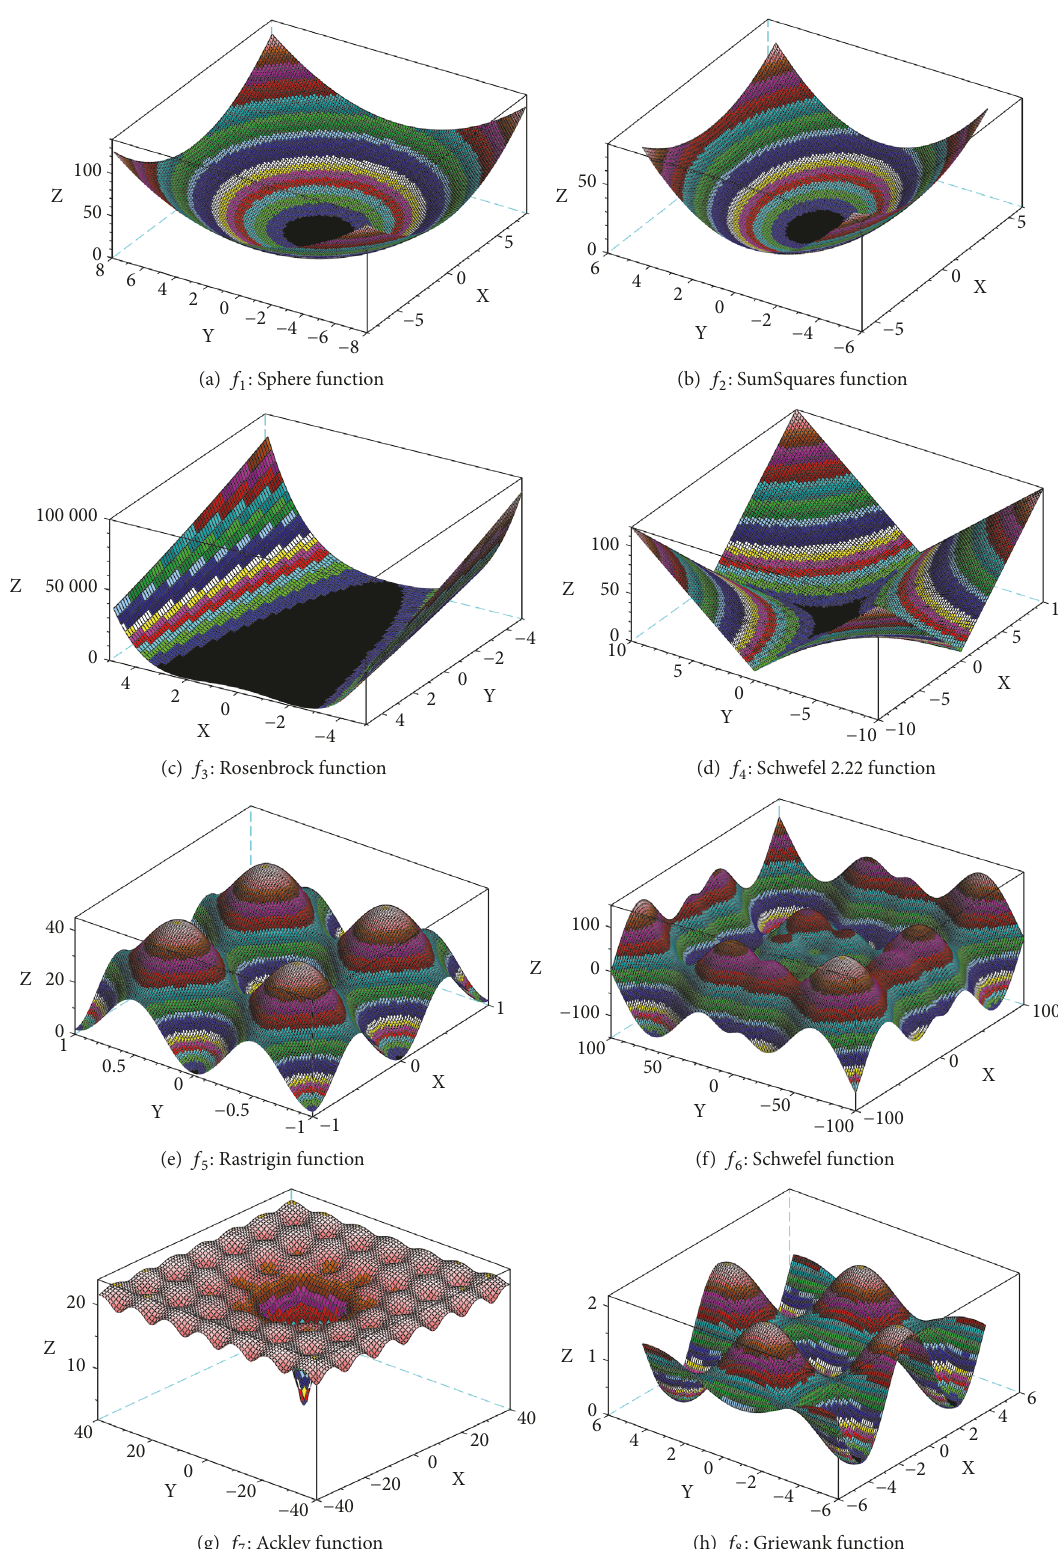
Figure 1: 2𝐷 Surface plots of the test